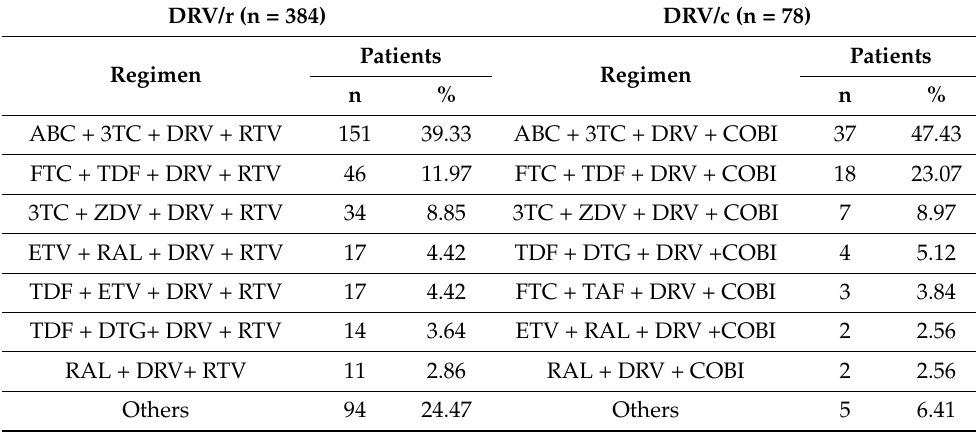
Figure 2. Therapeutic classes associated with DRV/r or DRV/c compared to the two groups (Excel, Microsoft). Legend: NRTI—nucleoside reverse transcriptase inhibitor; NNRTI—non-nucleoside reverse transcriptase inhibitor; PI—protease inhibitor; II—integrase inhibitor; EI—entry inhibitor; n—number of patients in group. Most patients in both groups (60.15% from DRV/r and 79.47% from DRV/c) received the same three regimens, the difference being represented only by the enhancer (Table 2). Table 2. Drugs included in the